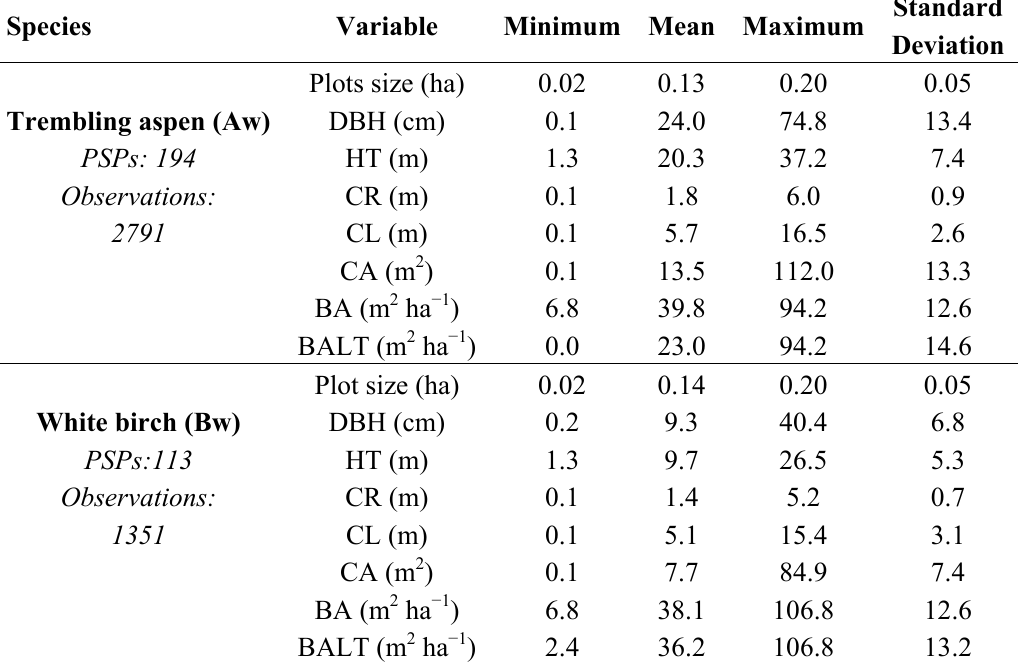
Table 1. Basic statistical information of selected variables for each broadleaf